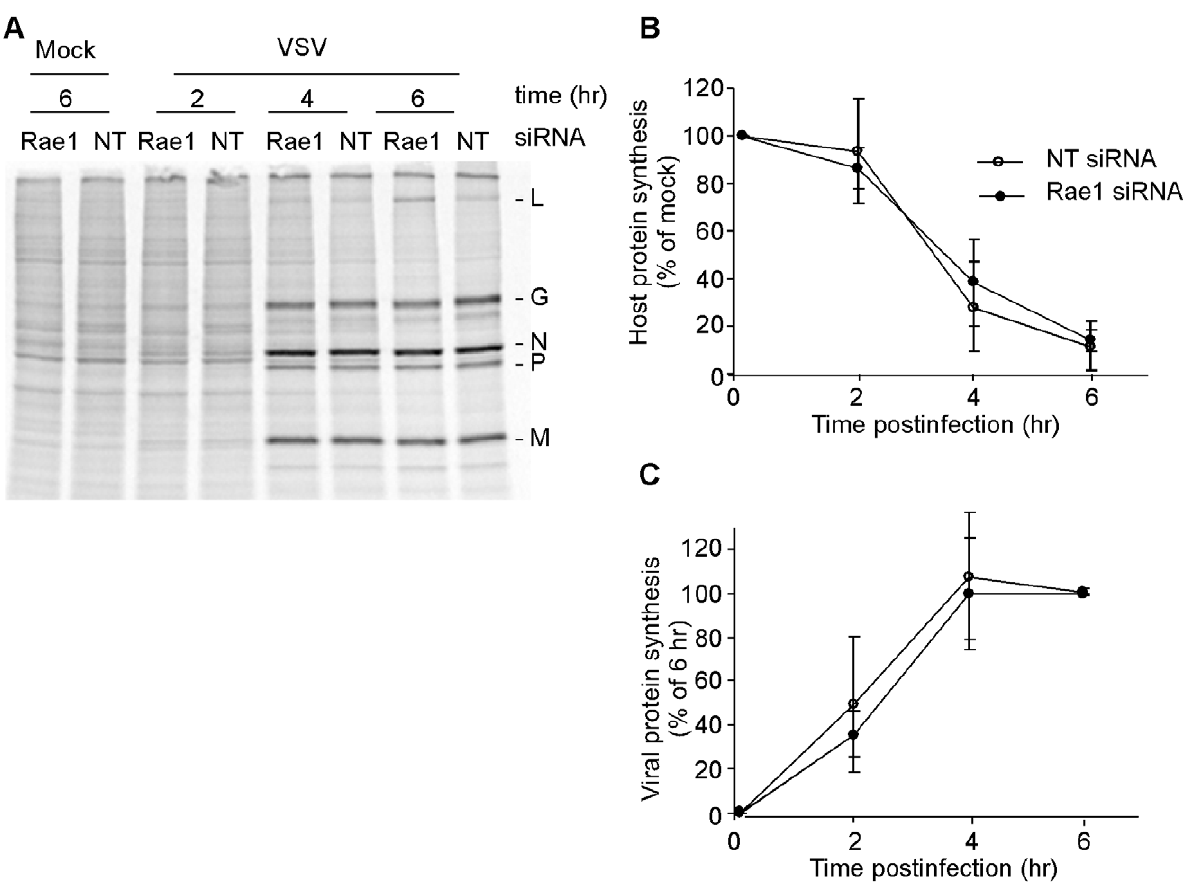
Figure 8. Effects of silencing the expression of Rae1 on host and viral protein synthesis. ( A ) HeLa cells were transfected with Rae1 siRNA or non-targeting (NT) siRNA. 72 hours post-transfection, cells were mock infected or infected with rwt virus for the indicated times and labeled with [ 35 S ] methionine for 10 min. Lysates from Rae1 siRNA cells or NT siRNA cells were analyzed by SDS-PAGE and phosphoimaging. Shown is a phosphoimage with the viral proteins indicated on the right. ( B ) Quantification of host protein synthesis expressed as a percentage of mock infected cells. Data shown are the means 6 standard deviation of three separate experiments. ( C ) Quantification of viral protein synthesis expressed as a percentage of synthesis at six hours postinfection. Data shown are the means 6 standard deviation of three separate